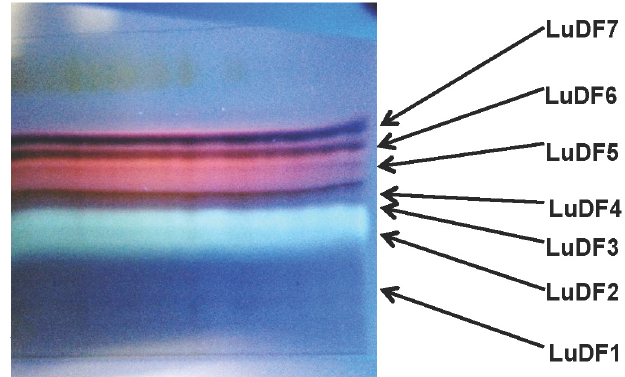
Figure 2. Thin layer chromatography (TLC) fractionation of a methylene chloride extract of L. ukambensis . Mobile phase: Cyclohexane/Ethyl acetate/Ethanol/Acetic acid (6/2/2/0.1). Plate was revealed under UV365 nm. LuDF: Lantana ukambensis Dichloromethane Fraction.